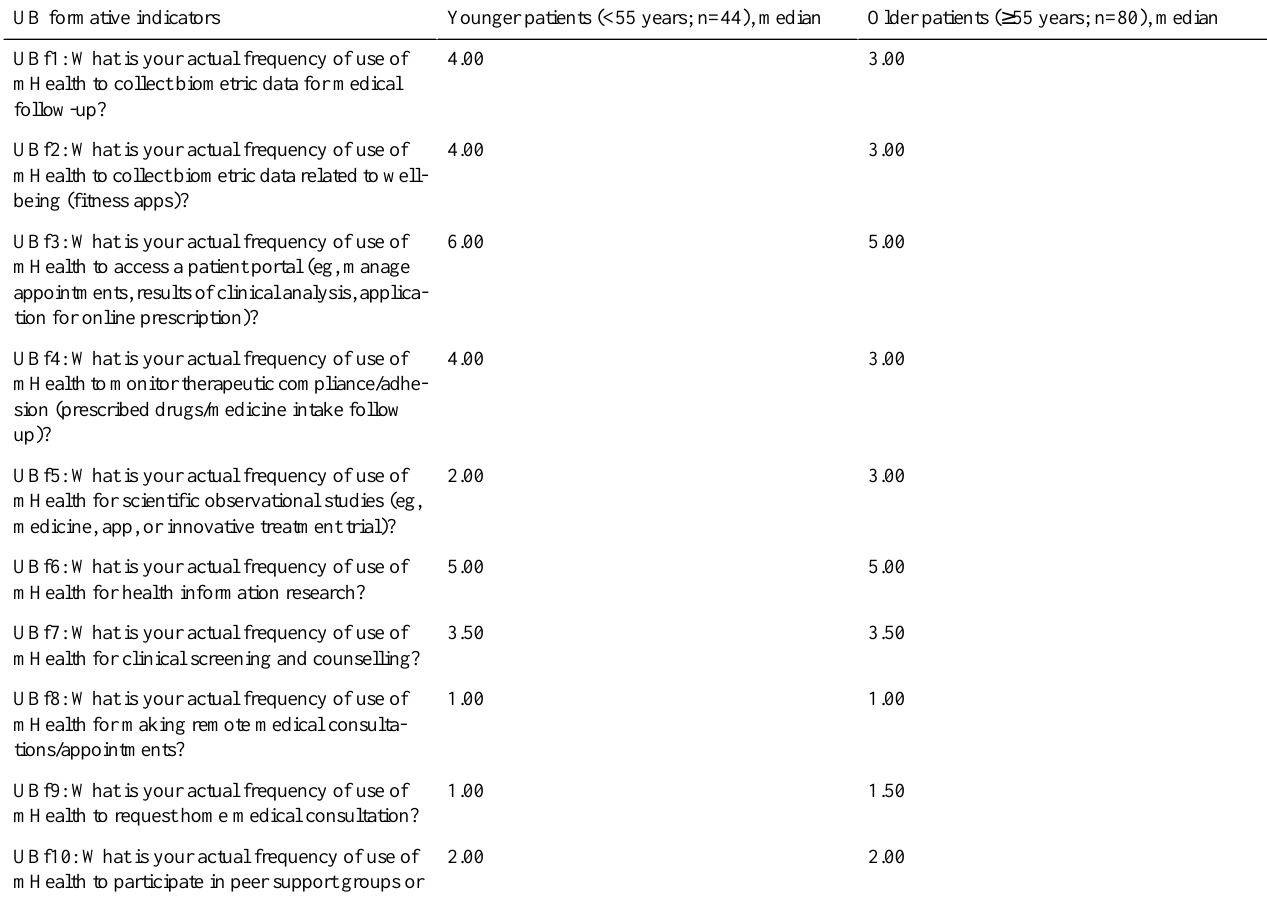
Table 9. Median use behavior (UB) formative indicators in patients with chronic conditions according to